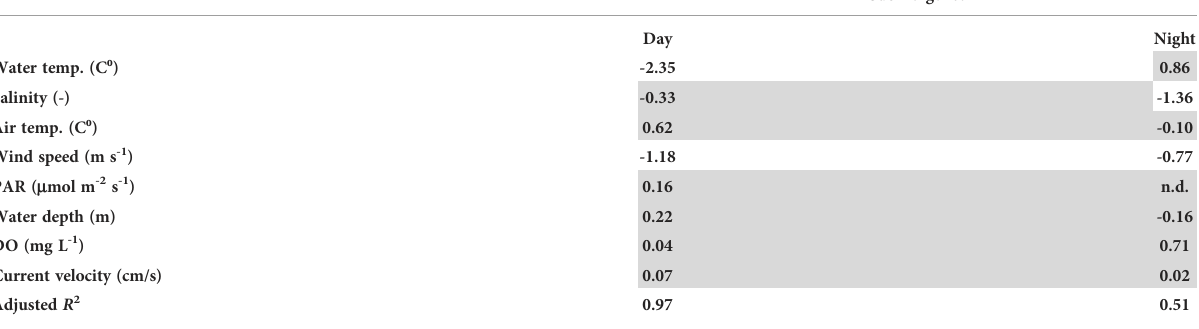
TABLE 2 Partial regression coef fi cients and coef fi cients of determination between the predictor variables and O2 exchange